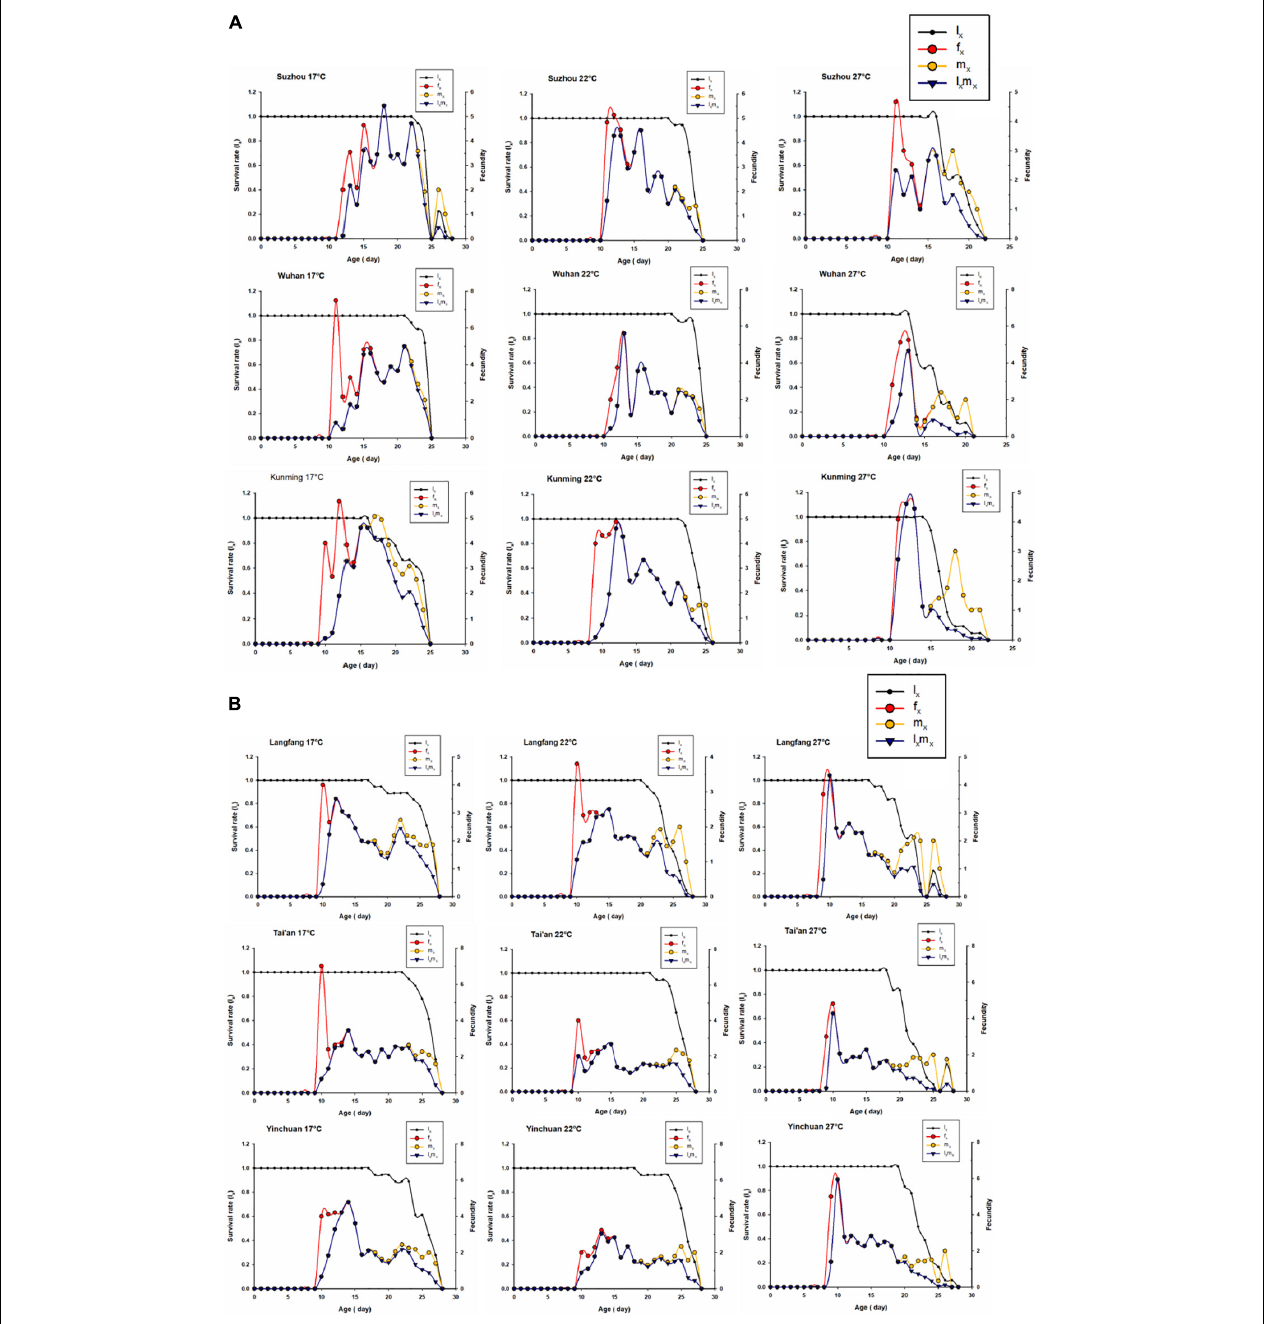
FIGURE 7 | Age-specific survival rate ( l x ), age-stage fecundity ( f xj ), age-specific fecundity (m x ), and age-specific maternity ( l x m x )of S. miscanthi on different geographical populations at different degrees (17, 22, and 27 ◦ C). (A) Southern populations (B) northern populations.